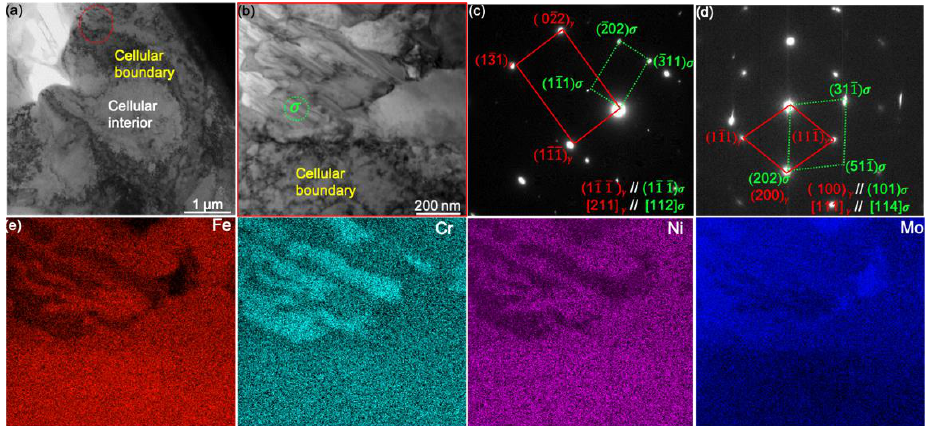
Figure 4. Lamellar-like σ phase nearby a MCS. ( a ) The BF-TEM image of σ phase. ( b ) A blow-up high-angle annular dark-field (HAADF) STEM image showing the lamellar structure. ( c , d ) The SADPs indicate the orientation relationship of γ matrix and σ phase along the zone axis of γ matrix: ( c ) [211] and ( d ) [111]. ( e ) The energy-dispersive spectroscopy (EDS) maps of Fe, Cr, Ni, and Mo distribution in the region shown in ( b